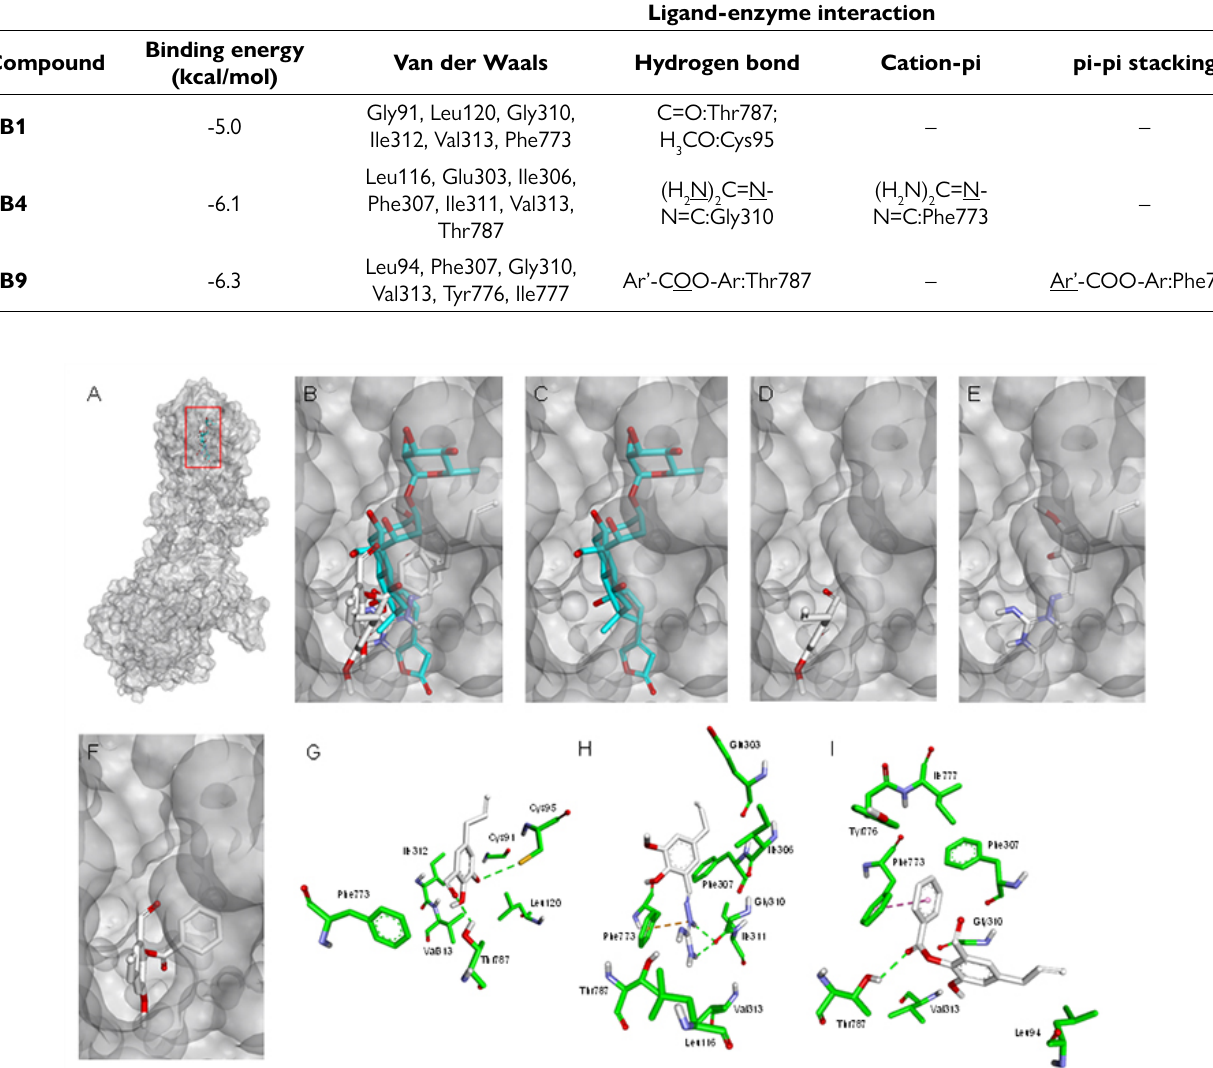
Table 3. Docking results for eugenol derivatives FB1, FB4, and FB9 to the channel of the S. mansoni Na+/K+-ATPase.